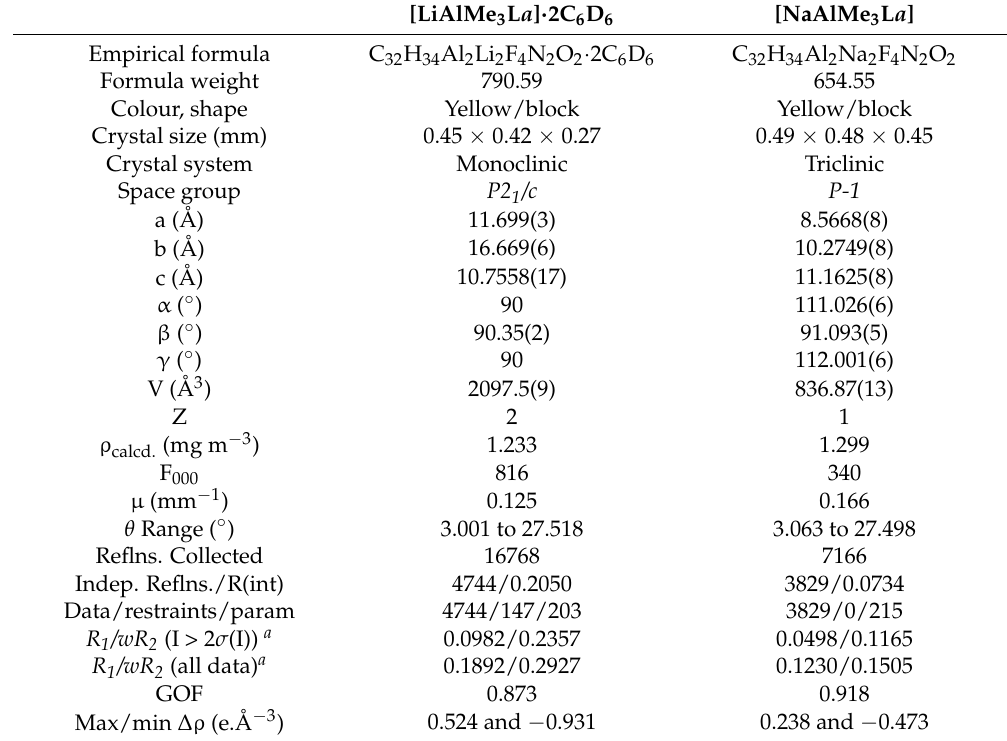
Table 1. Crystallographic data for 1 · 2C 6 D 6 , and 2